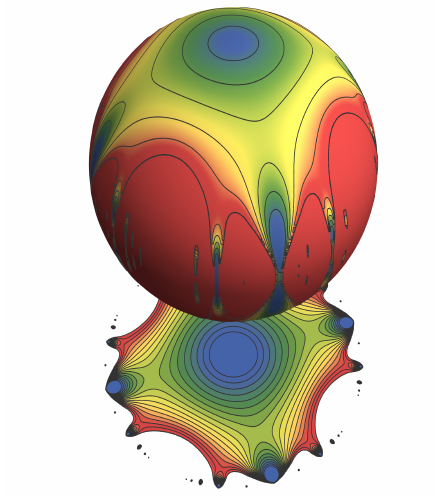
Figure 4. Inverse stereographic projection of the piecewise function L ( C ( 4 ) ; z ) for z < 1 and L ( C ( 4 ) ;1/ z ) for z > 1. Here, the natural boundary gets mapped to the equator. The northern hemisphere is the image of the interior of the unit disk, while the southern hemisphere is the image of the exterior of the unit